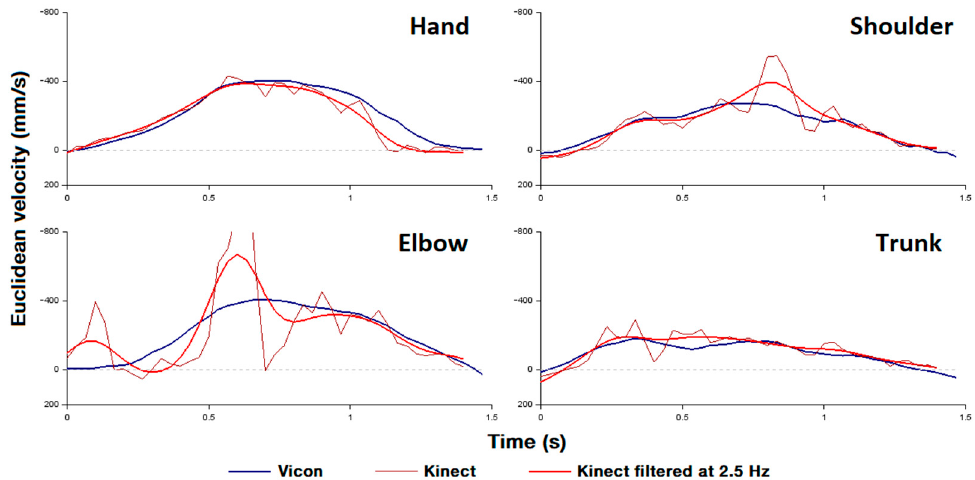
Figure 2. A selected example of the Euclidean velocity of a typical subject’s hand, shoulder, elbow, and trunk before and after filtering for the Kinect. The dashed line represents a constant Euclidean velocity of 0 mm · s − 1 . The figure shows how low-pass filtering reduces the instantaneous velocity errors of the Kinect compared to the Vicon measurements.